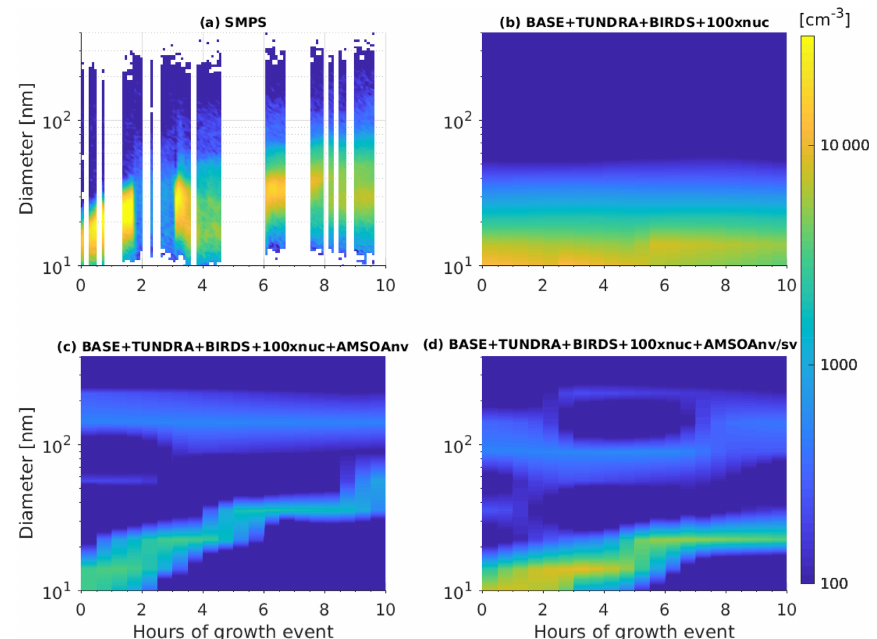
Figure 7. Time series of size-resolved aerosol number distributions (color contours show d N/ dlog 10 D p ) for the growth event from 14 to 15 August 2016 as (a) observed along the Amundsen ship track (described in Sect. 2.1) and for the GEOS-Chem-TOMAS simu- lations along the ship track: (b) BASE + TUNDRA + BIRDS + 100xnuc, (c) BASE + TUNDRA + BIRDS + 100xnuc + AMSOAnv, and (d) BASE + TUNDRA + BIRDS + 100xnuc + AMSOAnv/sv. Simulations are described in Table 1 and Sect. 2.3.